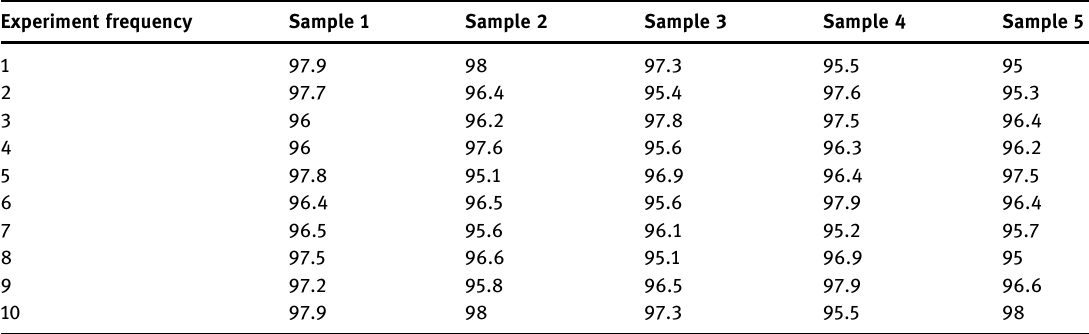
Experiment frequency